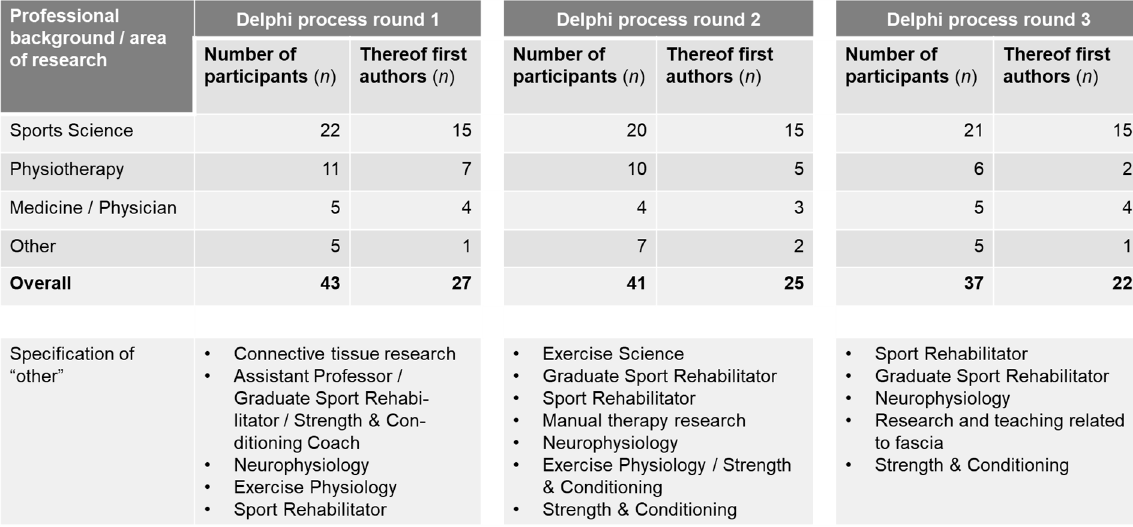
Table 3. Delphi process round 3 responses. Figures highlighted in grey met the a priori defined criteria for contraindications/cautions.